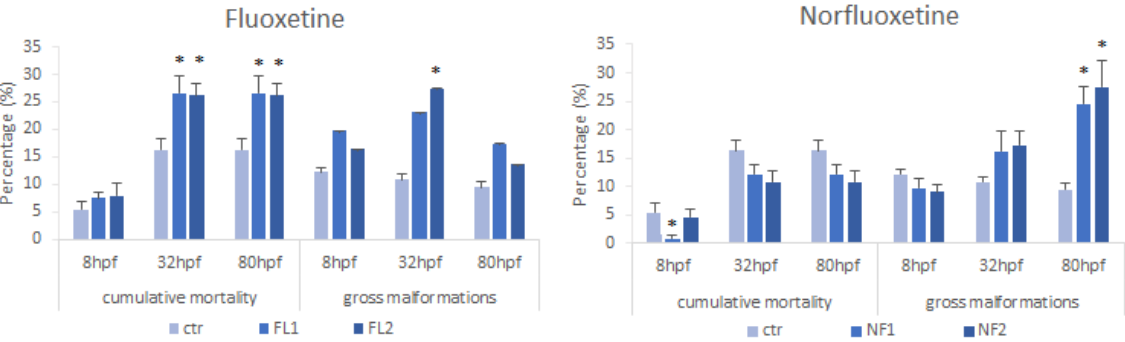
Figure 1. Cumulative mortality and rates of gross malformations recorded in embryos and larvae of zebrafish exposed to 0.0015 and 0.05 µ M fluoxetine (FL1 and FL2, respectively) (left graph) or 0.00006 and 0.0014 µ M norfluoxetine (NF1 and NF2, respectively). Results are expressed as mean ± SE. * indicates statistically significant differences in relation to the solvent control (ctr) ( p < 0.05).